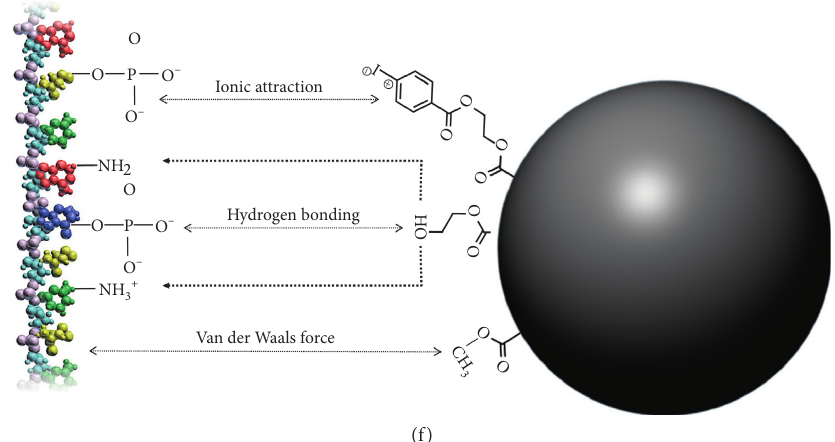
Figure 4: Performance analysis of the microspheres for detection of miR159: (a) calibration curves plotted for different size categories of the spheres in varied concentrations of the labeled miRNA (1 nM, 10nM, 100nM and 1000nM, 100pM, 10pM, and 1 pM); (b, c) fluorescence images of the spheres (MMS-3 as the representative) after detection of 1nM and 100nM of the labeled miRNA, respectively; (d) per- formance analysis of the spheres via indirect detection of miRNA in comparison to the cutoff values, which are twice that of the average negative controls calculated for different size categories (concentration of the labeled miRNA � 1nM); (e) relative fluorescence signal resulting from competitive assay conducted with a mixture of fluorescent Cy3-miR159 (concentration: 1000nM or 100nM) and non- conjugated miR159 at different concentrations (1000, 100, and 10 nM); and (f) schematic representation of the possible physical interactions between the sphere’s surface and a capture probe.